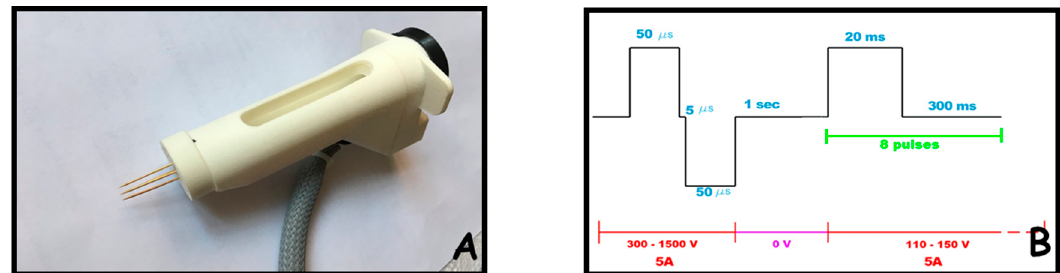
Figure 5. The original needle electrodes and electrical parameters designed for electroporation. Panel ( A ) the needle array electrode used for electroporation is depicted; it consists of a handle where a syringe can be lodged surrounded by a changeable four-needle array, connected to the impulse generator. Panel ( B ) schematic representation of the electrical parameters used for electroporation.